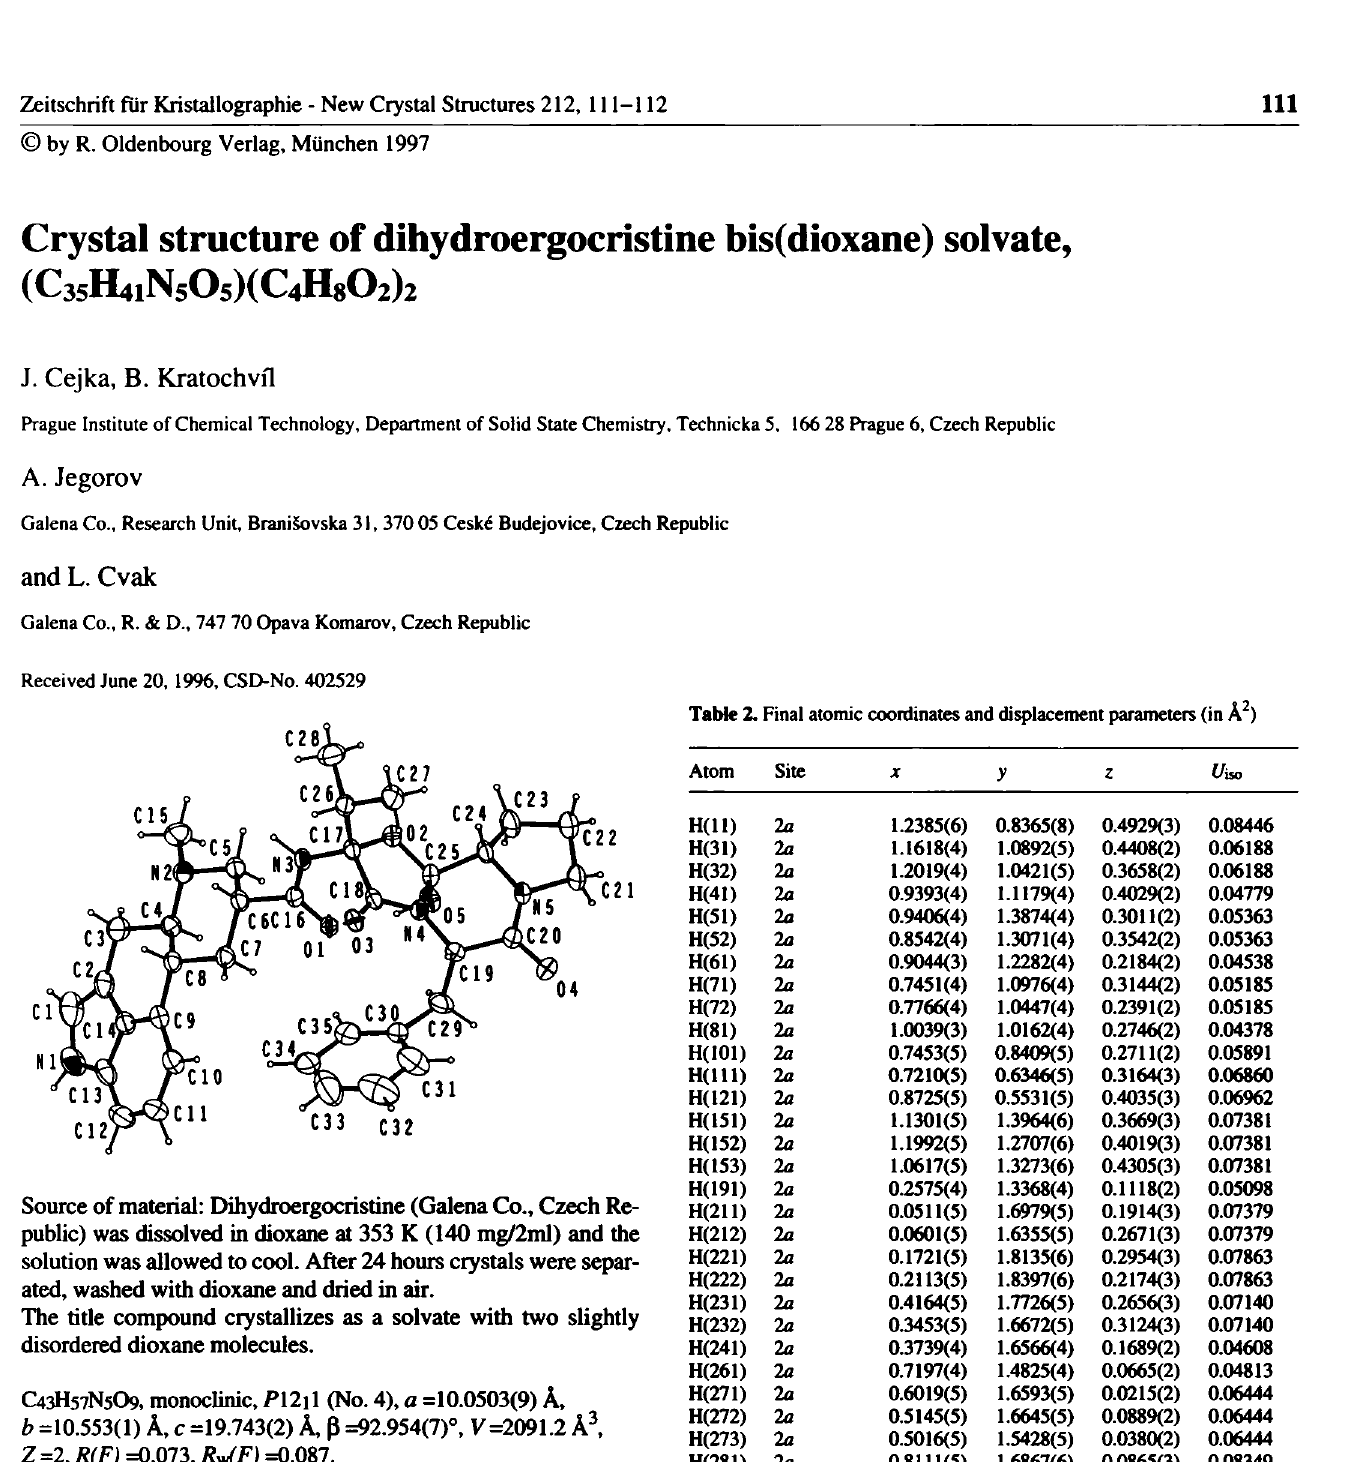
Table 1. Parameters used for the X-ray data collection Crystal: